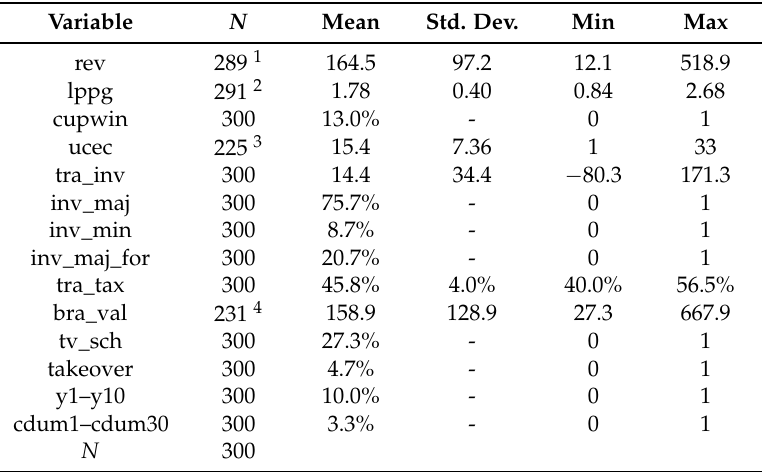
Table 6. Summary